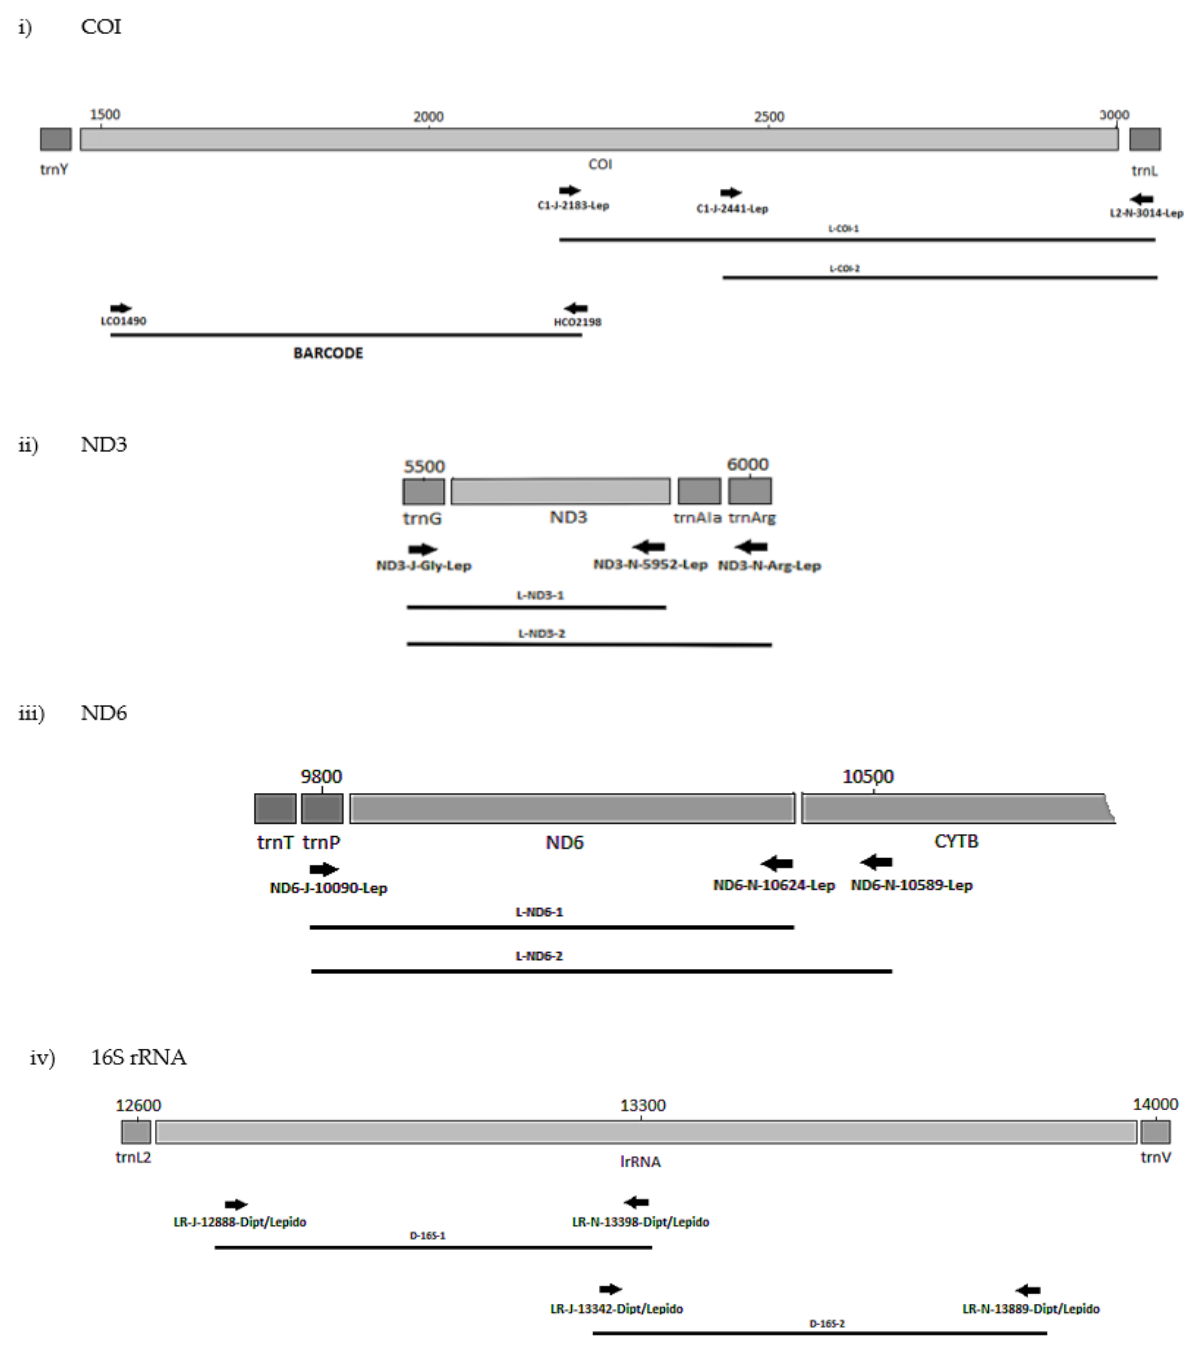
Figure 2. MLSA primer positions for Lepidoptera genes ( i ) COI, ( ii ) ND3, ( iii ) ND6 and ( iv ) 16S.